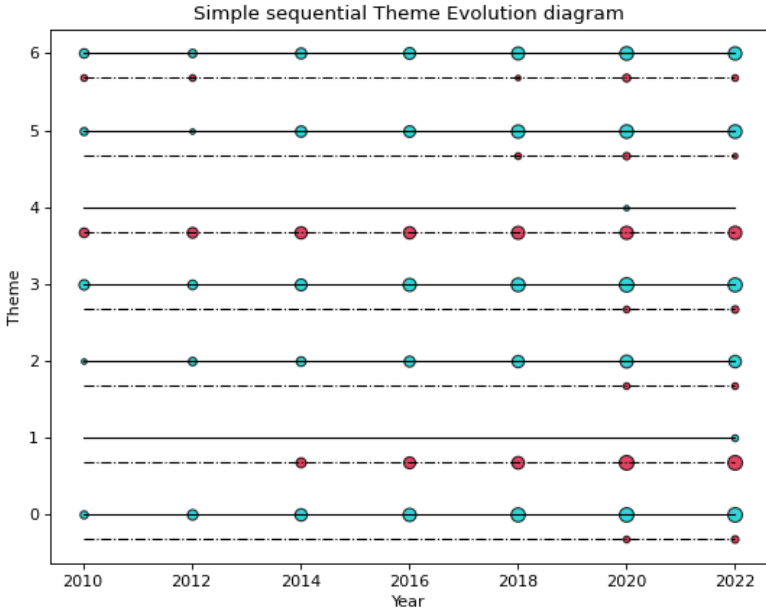
Figure 4. Multi-source data time-series theme-evolution diagram.